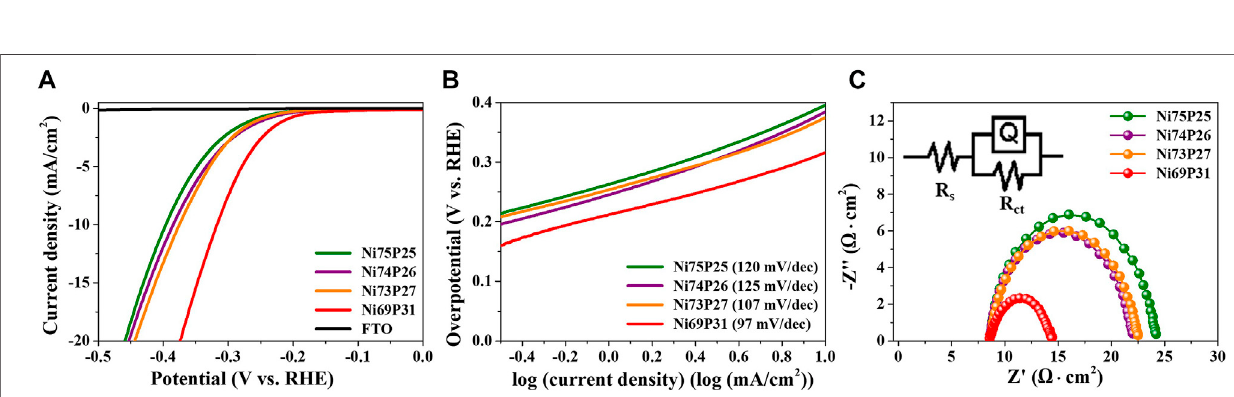
Frontiers in Chemistry |